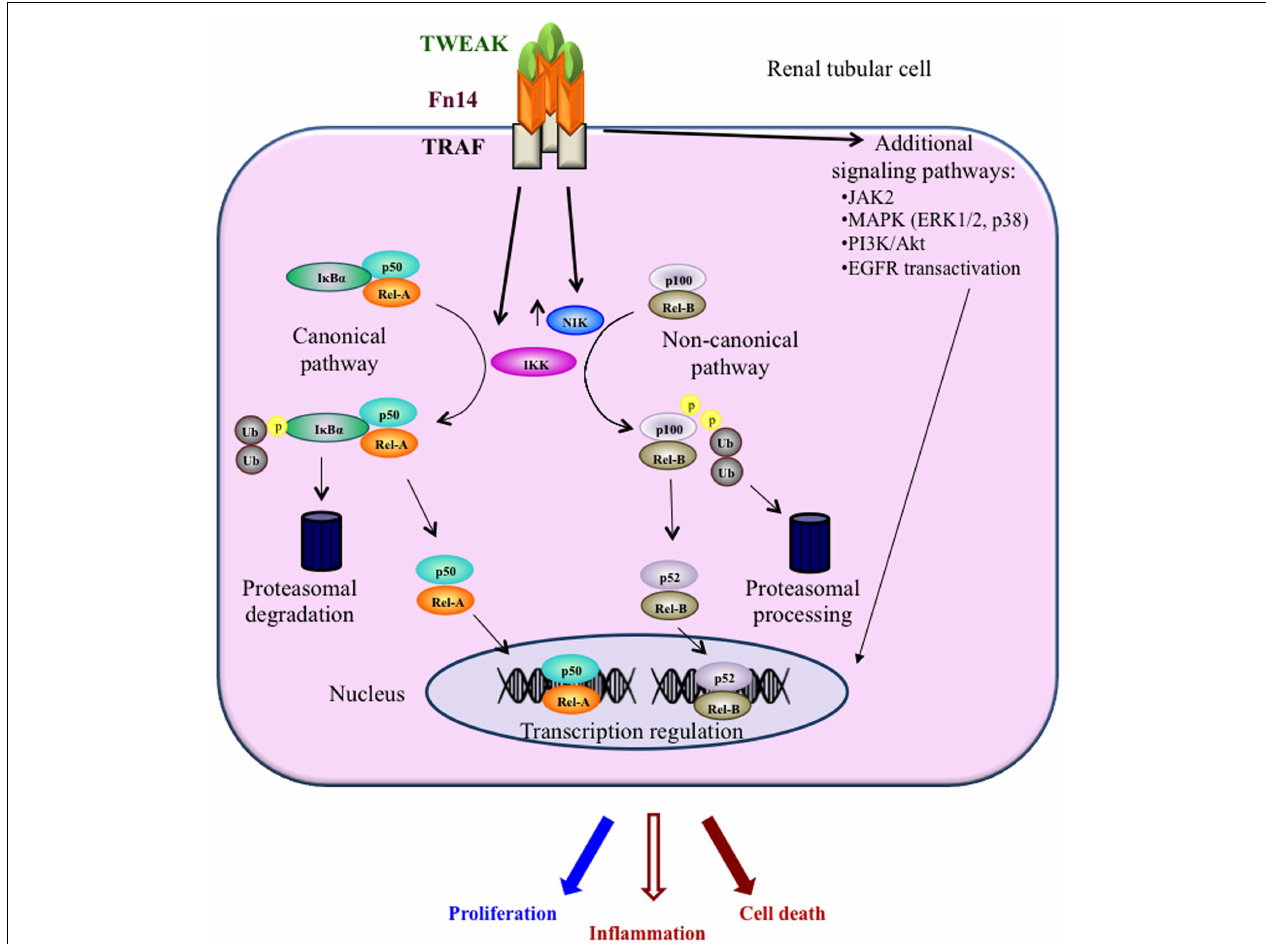
FIGURE 1 | Key intracellular pathways activated byTWEAK engagement of Fn14 in kidney tubular cells .TWEAK signaling in kidney cells has been characterized most in detail in tubular cells.TWEAK engages both the canonical and the non-canonical NF κ B pathways and kinase signaling